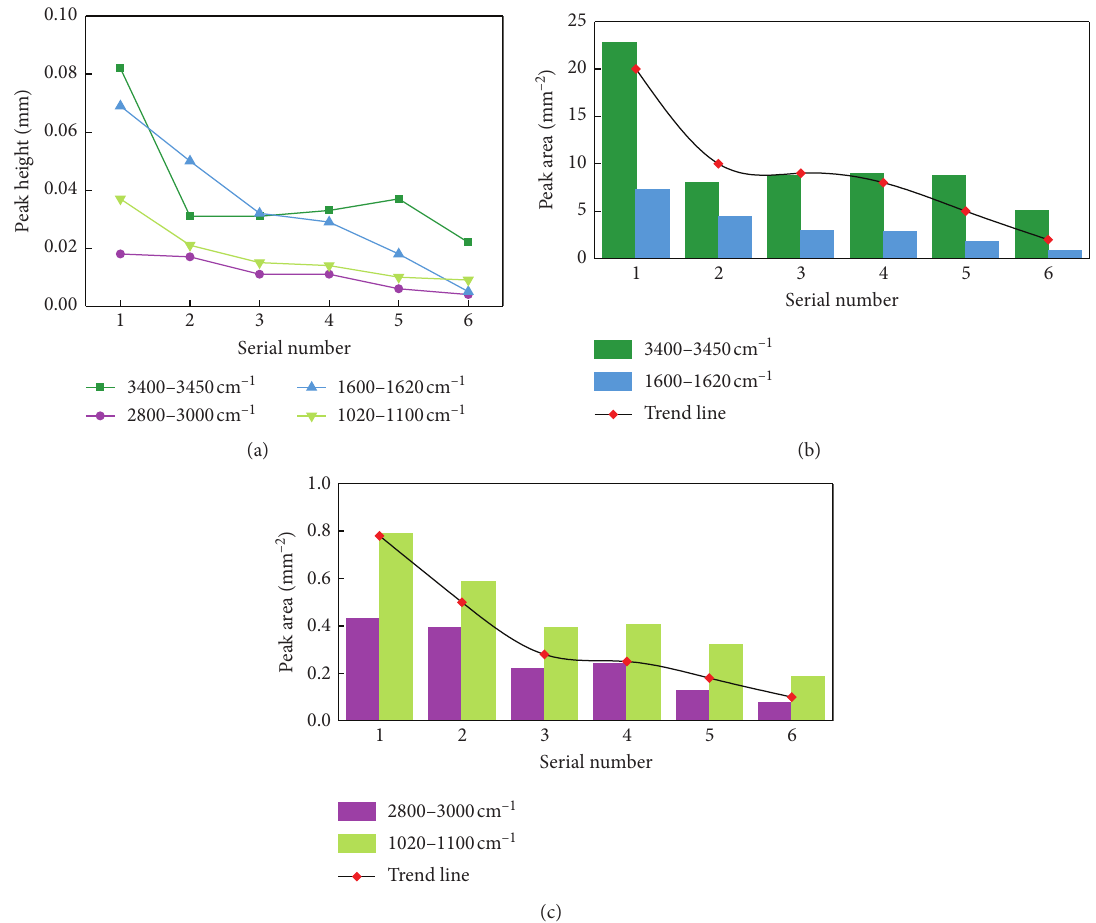
Figure 5: Heights and areas of the characteristic peaks of the oxygen-containing functional groups: (a) heights of the characteristic peaks; (b) areas at the characteristic peaks of 3400–3450cm − 1 and 1600–1620cm − 1 ; (c) areas at the characteristic peaks of 2800–3000cm − 1 and 1020–1100cm − 1